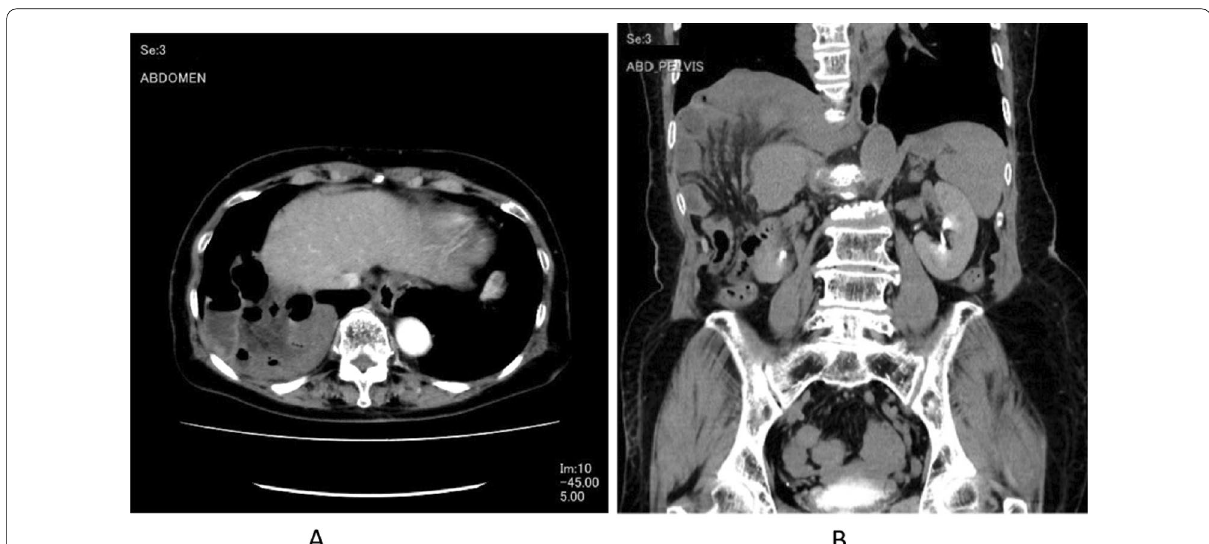
Fig. 2 A Contrast-enhanced computed tomography (CT). Contrast-enhanced CT showing herniation of the small intestine into the thoracic cavity. B Coronal CT image. Coronal CT images showing loops of the small intestine in the thoracic